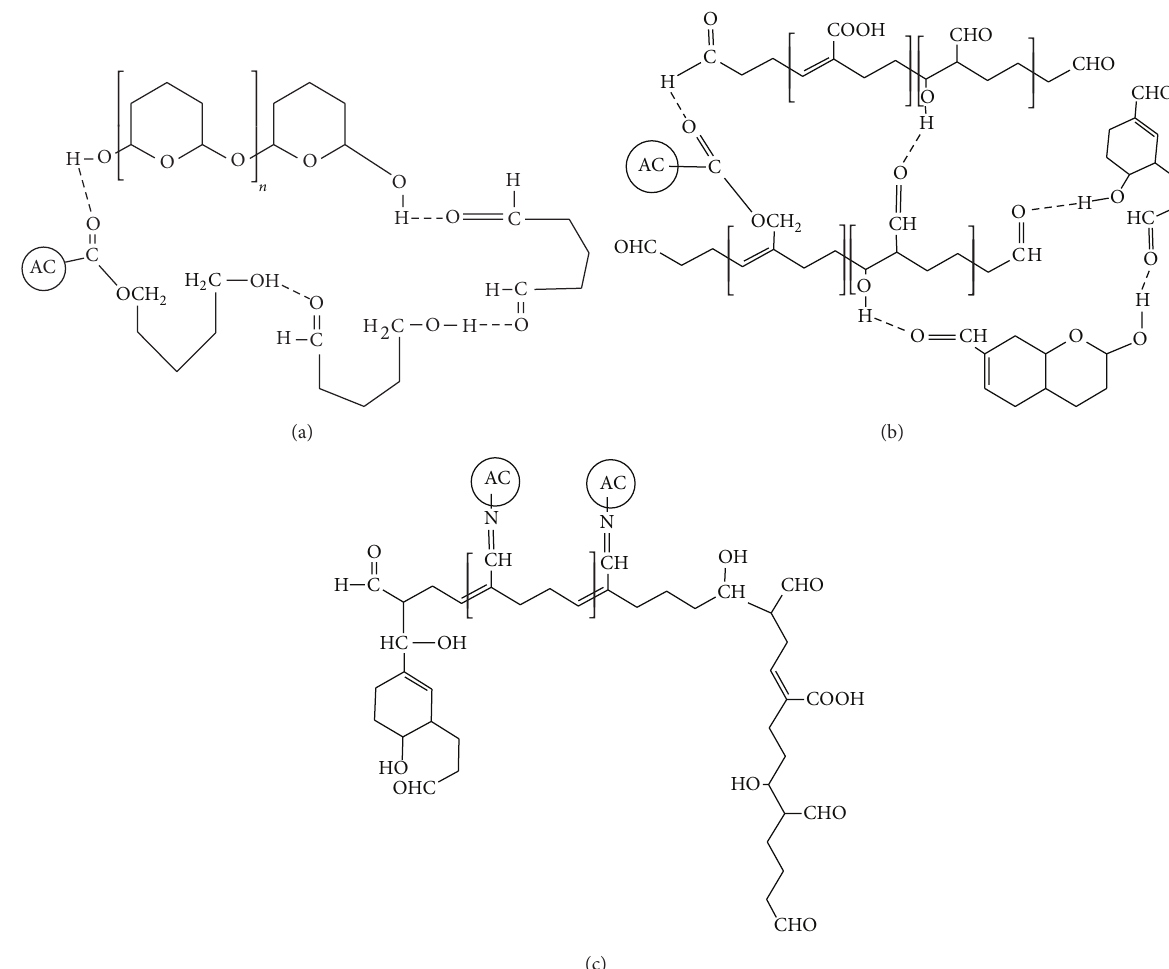
Figure9:Schematicillustrationsofpossibleglutaraldehydecooperativeadsorptionmechanisms:(a)hydrogenbonding,pH < 7;(b)hydrogen bonding, pH > 7; and (c) aldol condensation, strong alkaline pH. Table 5: Batch kinetics rate constants for sorption of glutaraldehyde on EDA-AC.